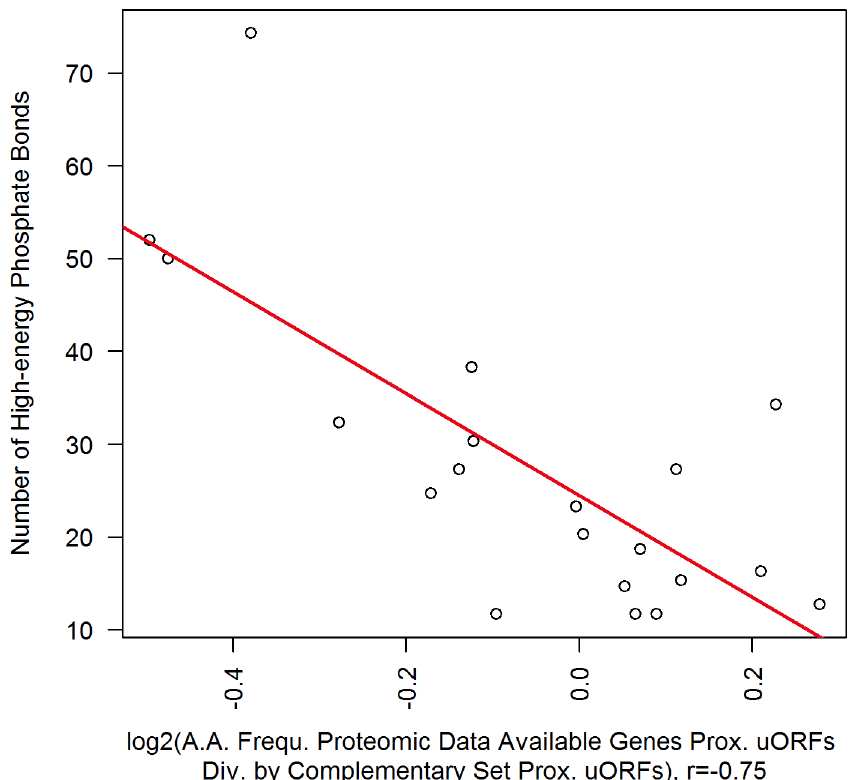
Fig 7. Proximal uORFs in highly important genes contain optimized amino acids. Each of the 20 proteinogenic amino acids is represented by one scatter. The subset of genes, which provided significant signal for acquisition of proteomic data, are presumably among the most translated (see text for details). The x-axis plots are the quotient of amino acid frequencies throughout uORFs in the subset of genes with available proteomic data. Positive values represent amino acids more frequently used throughout uORFs in the extensively translated genes, and mostly correspond to metabolically low-cost amino acids (bottom right quadrant of the figure). The figure employs the set of genes with available proteomic data exemplary as an extensively translated subset. Respective r values for tandem and top CAI genes, which are also presumably among the most translated genes, are -0.75 and -0.72. (Of 1628 proximal uORFs, n tandem = 45, n proteomic = 159 and n topCAI = 91 uORFs are included in the three subsets of highly expressed genes).